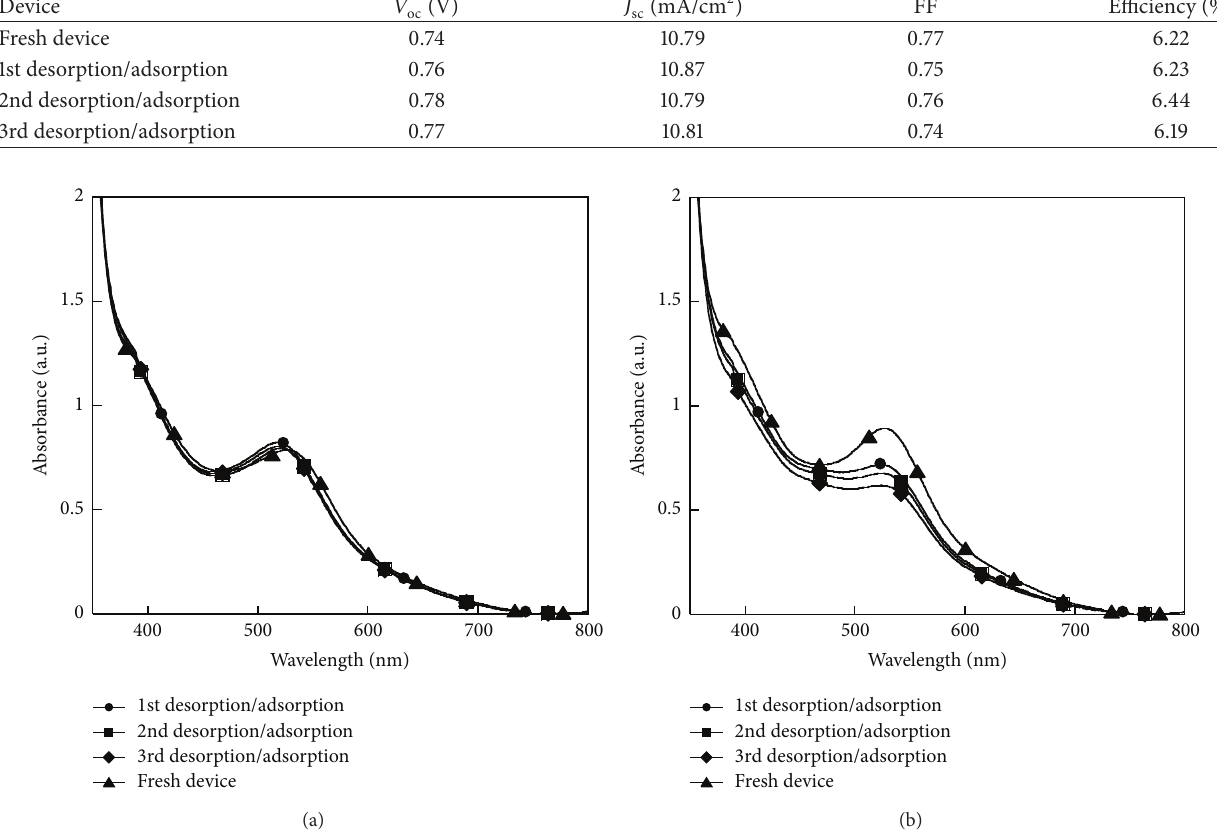
Table 2: The photovoltaic performance of DSCs under multiple adsorption/desorption processes using NaOH solution as desorption agent. Device